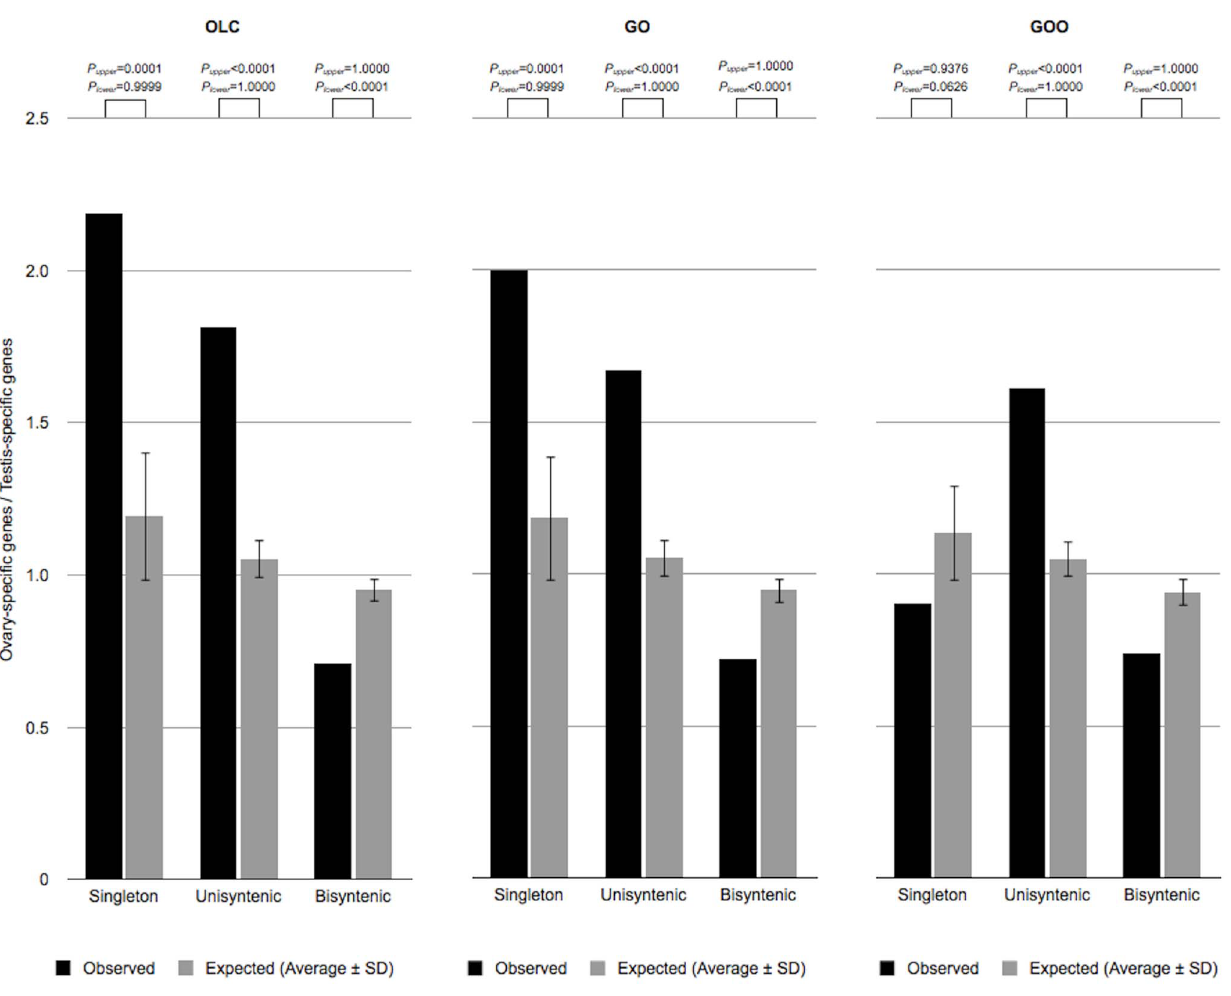
Figure 3. Association between gonadal gene expression and the evolution of gene order. Singleton and unisyntenic genes represent genes where gene order was disrupted at one or both sides in the Drosophila genus, respectively. Bisyntenic genes represent genes with complete gene order stability in the Drosophila genus (see main text for detailed definitions). The association between gene order stability/disruption and gonadal specific gene expression was studied according to three reconstructions of Drosophila genus gene order evolution: OLC, GO, and GOO (see main text for definitions). Expected measures were obtained after random permutation of testis- and ovary-specific gene tags, respecting their chromosome arm distribution (10,000 replicates). P upper and P lower values represent the fraction of random simulations with measures larger or equal, and lower or equal than the observed ones, respectively.